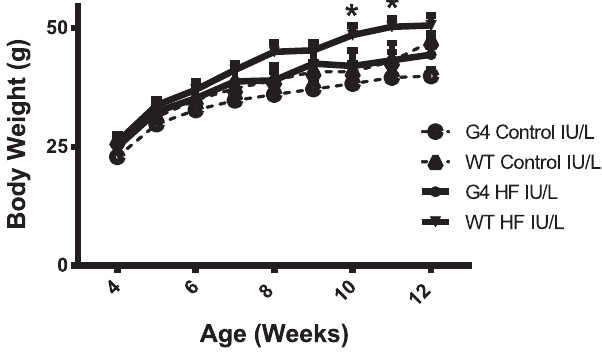
Figure 1. Body weight (BW) gain for WT and G4 + / 2 male offspring exposed to Control or HF IU/L. BW, measured